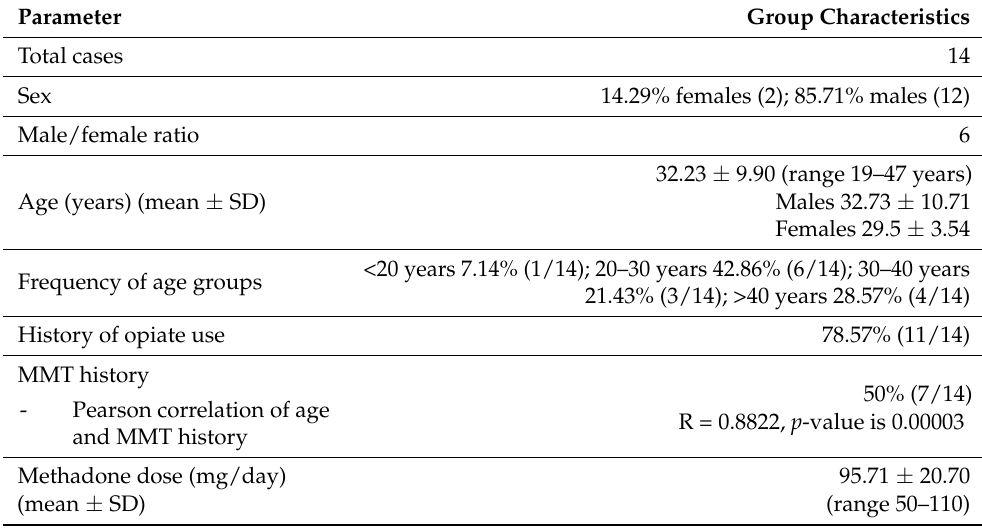
Table 2. Demographic and toxicological characterization of the study